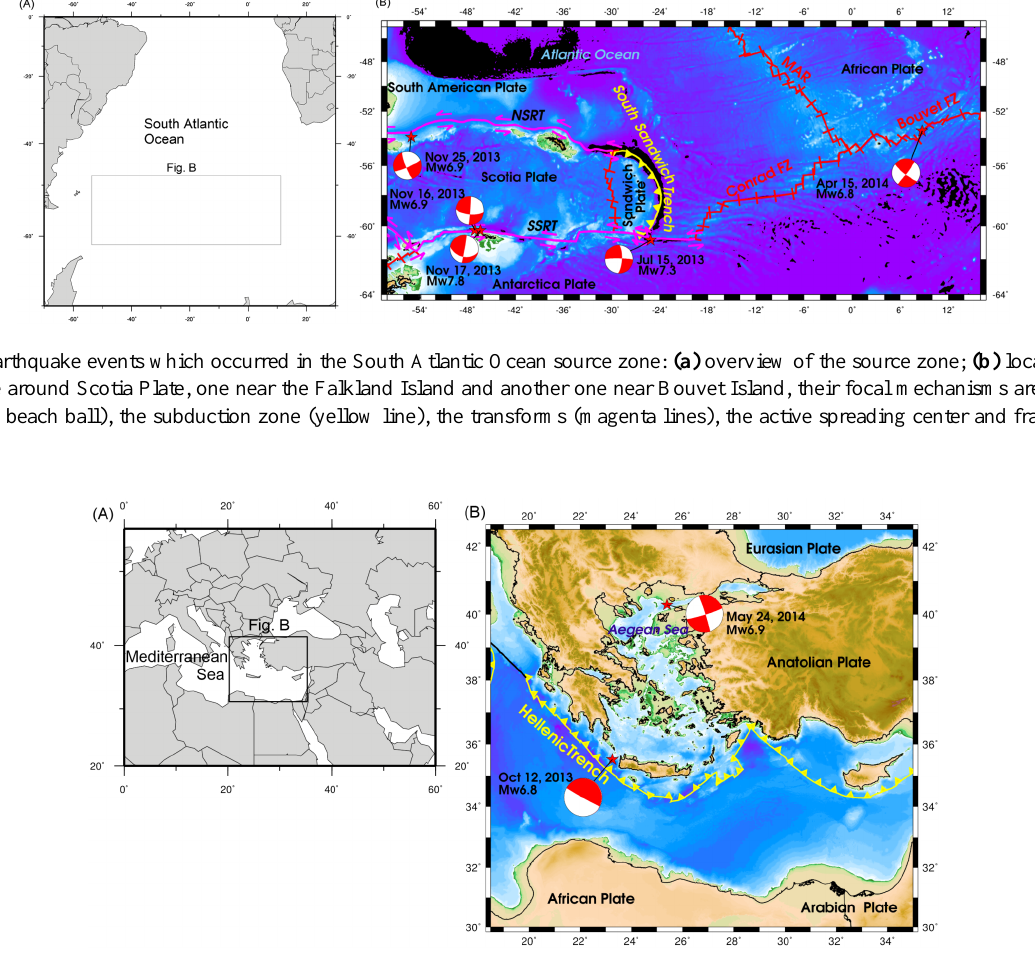
about 2 m were recorded (Table